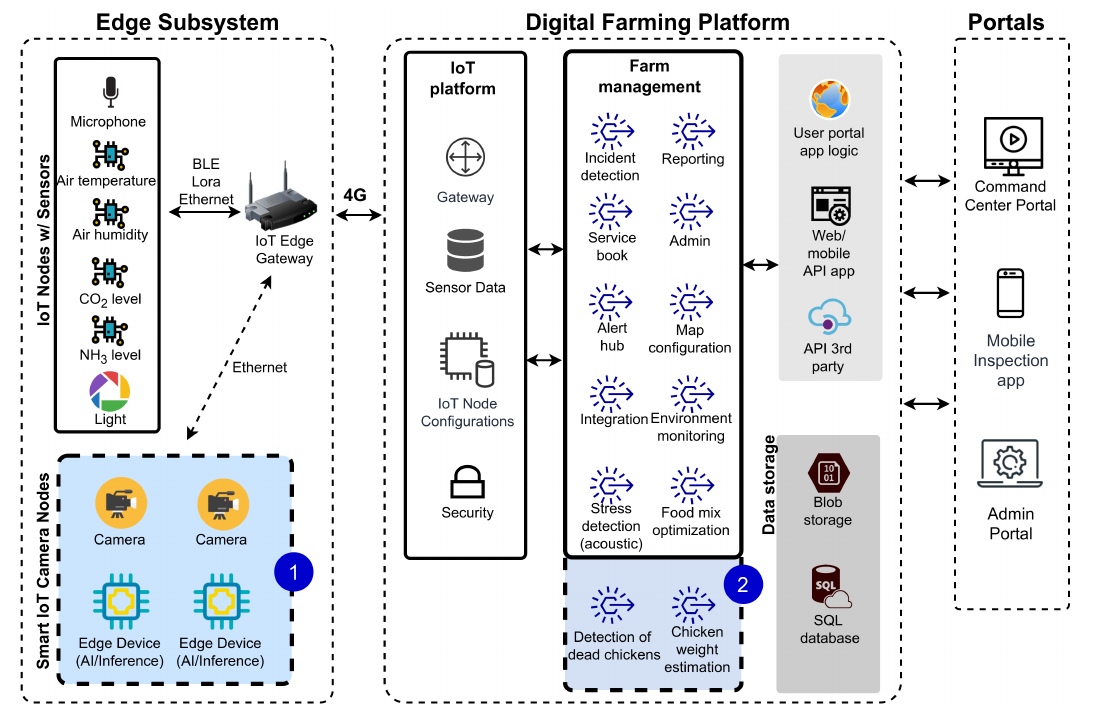
Figure 1. A high-level system architecture of the IoT-based platform for smart poultry